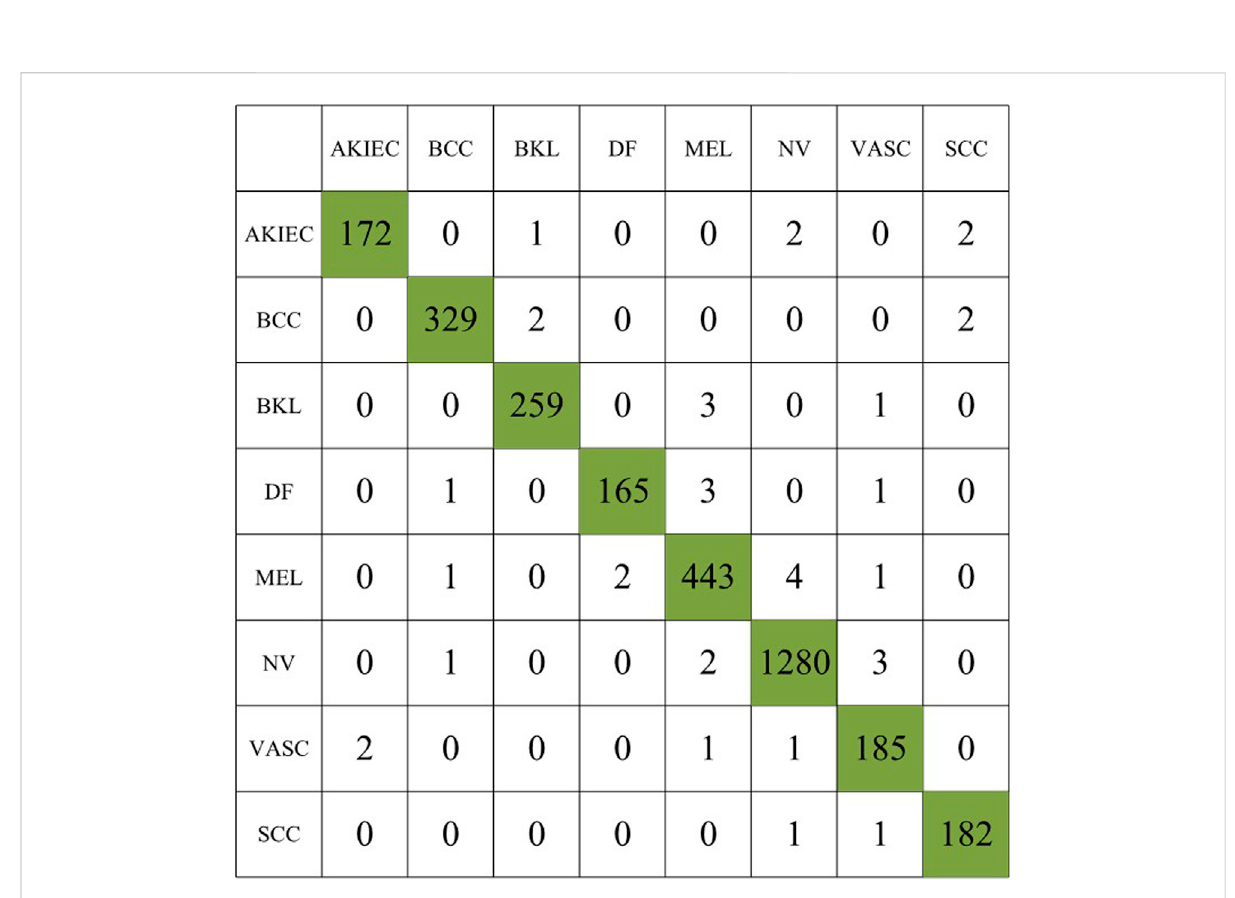
FIGURE 7 Confusion matrix for the third